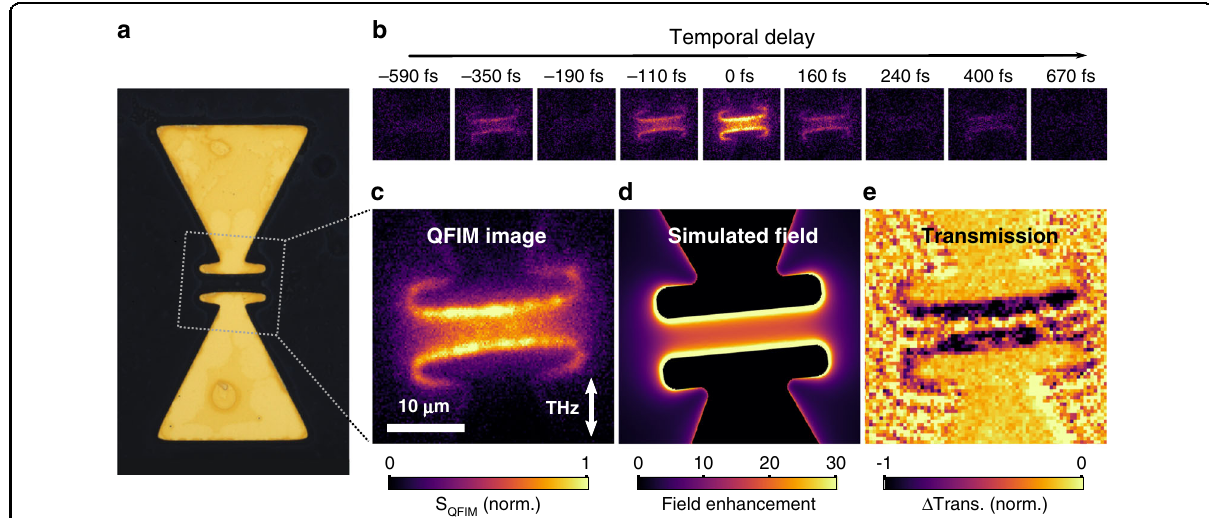
Fig. 2 Evolution of THz near- fi elds in a resonant bowtie antenna. a Optical micrograph of the THz bowtie resonator. b A series of subsequent microscopic snapshots at selected delays tracks the THz near- fi eld with sub-cycle temporal resolution (incident THz polarization as indicated). c QFIM snapshot at the peak local fi eld at Δ τ = 0 fs. d The simulated spatial near- fi eld distribution at resonance in the gap region closely resembles the QFIM signal in ( c ). e A snapshot acquired in transient transmission contrast ( Δ τ = 0 fs) corroborates the fi eld-driven absorption modulation as the origin of the QFIM signal